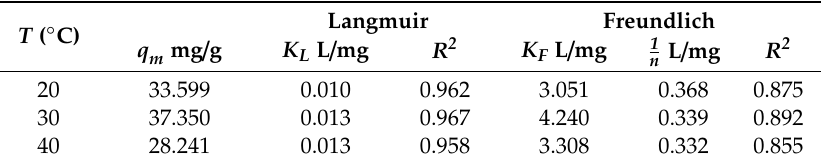
Table 3. Adsorption isotherm parameters of SLPS for